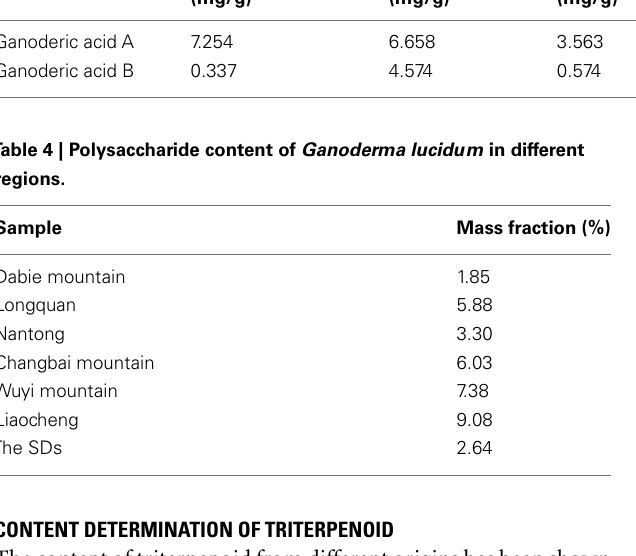
Table 3 | Six kinds of ganoderic acidA and ganoderic acid B content. Category